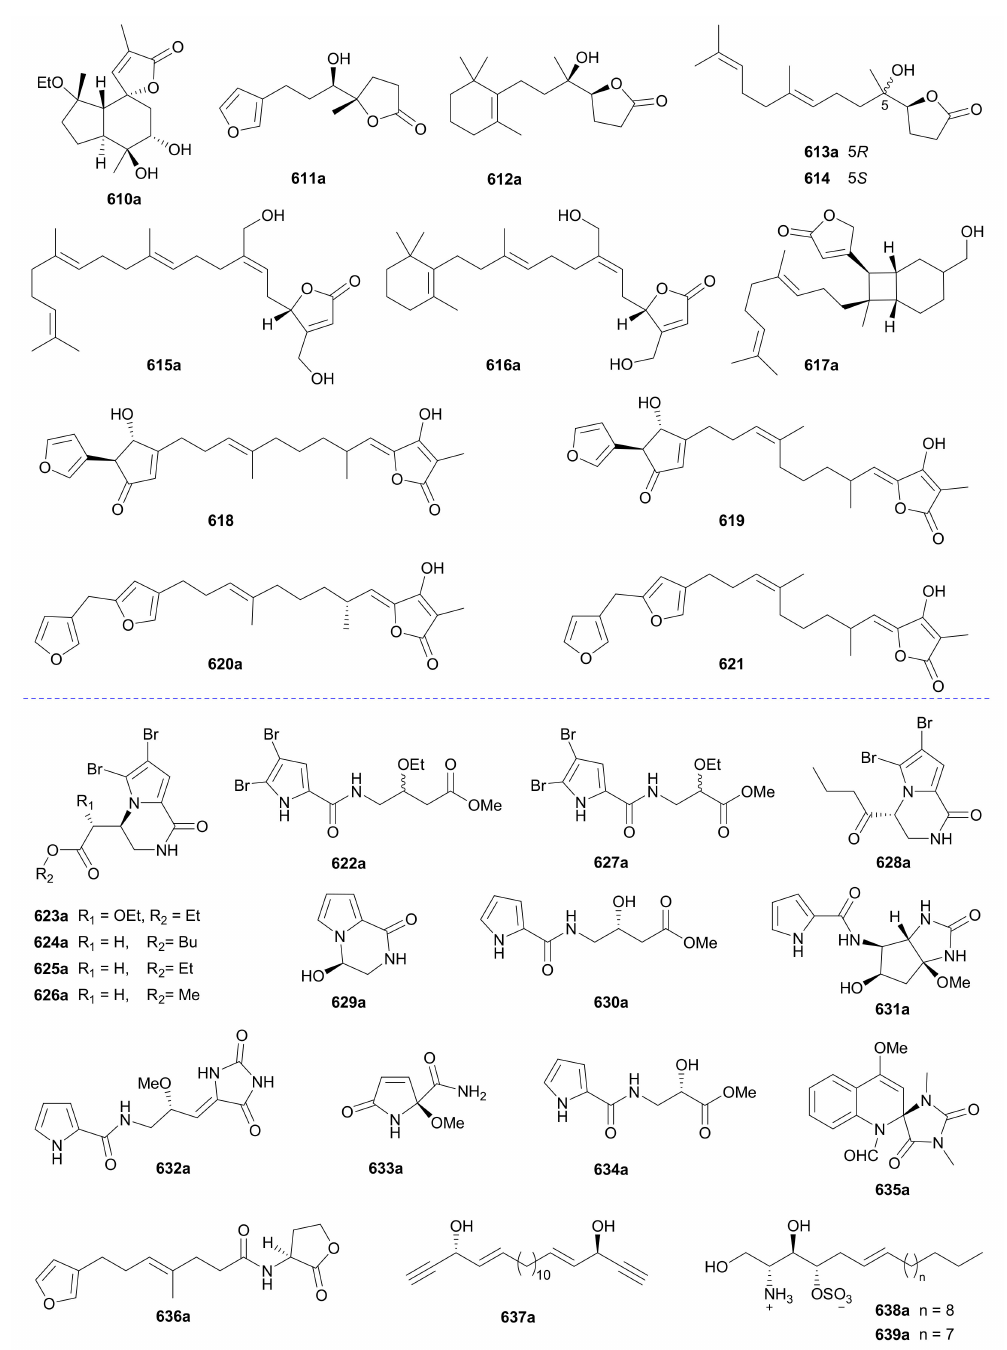
Figure 33. Structures of metabolites from phylum